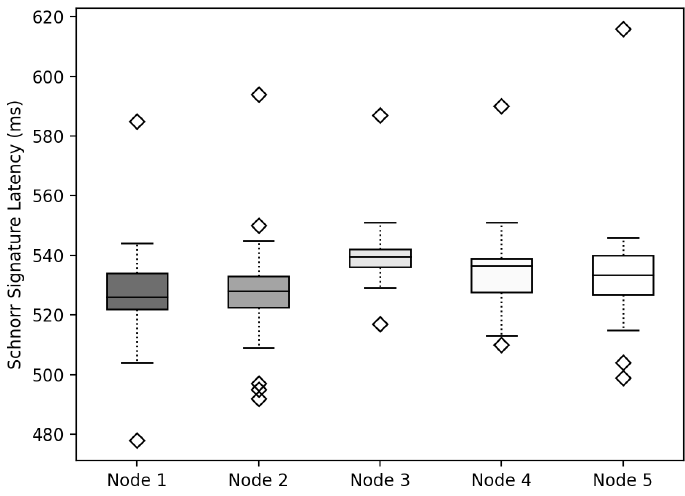
Figure 14. Latency measurement results for generating Schnorr